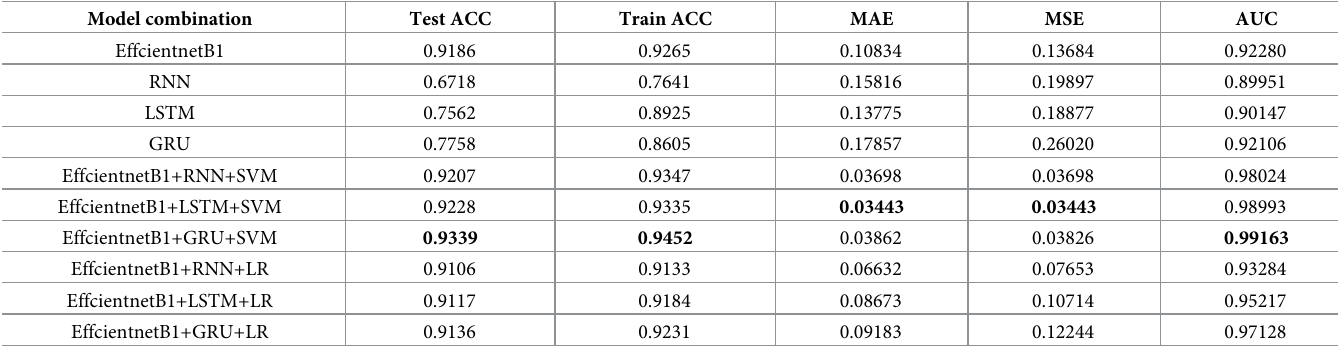
Table 4. Table of experimental results of the fusion